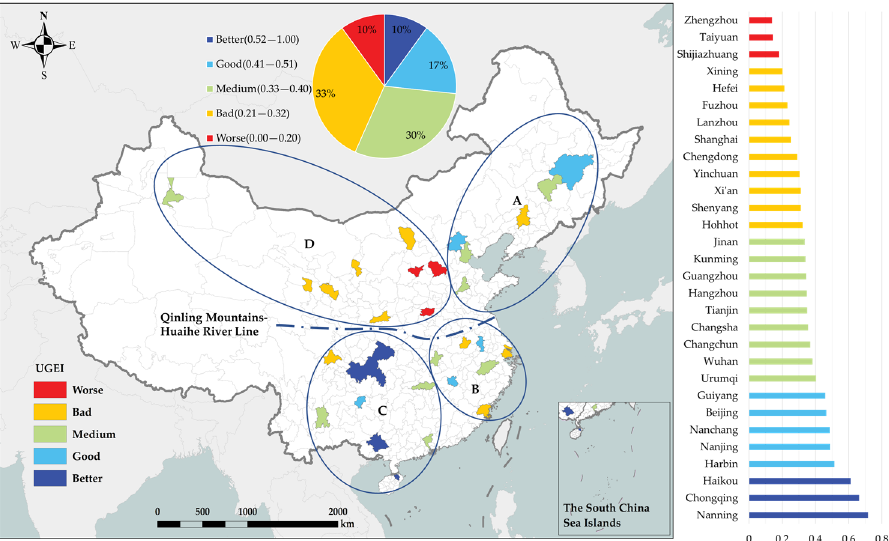
Figure 11. UGEI distribution map of the provincial capitals in China. A, B, C, and D represent the four regions obtained from clustering. The blue elliptical cluster borders represent the geographic extent of each UGEI cluster.